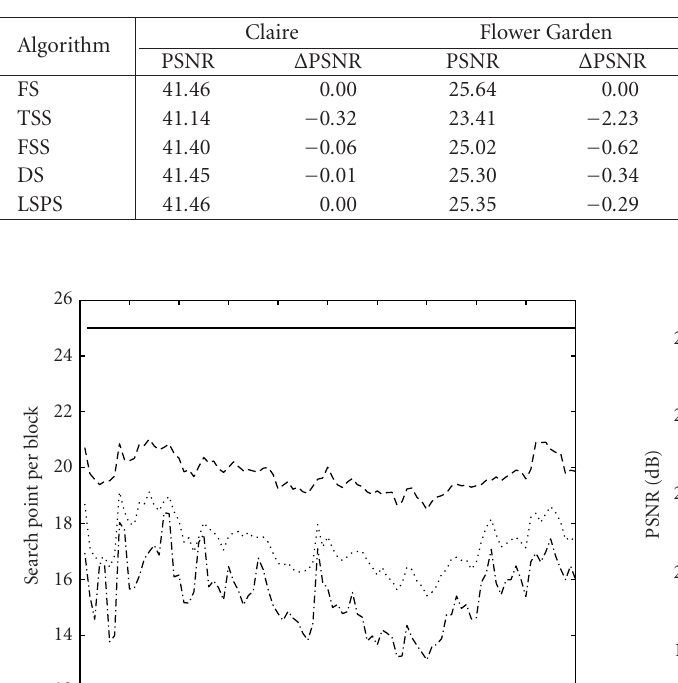
Table 3: Comparison between di ff erent BMAs in terms of prediction quality.